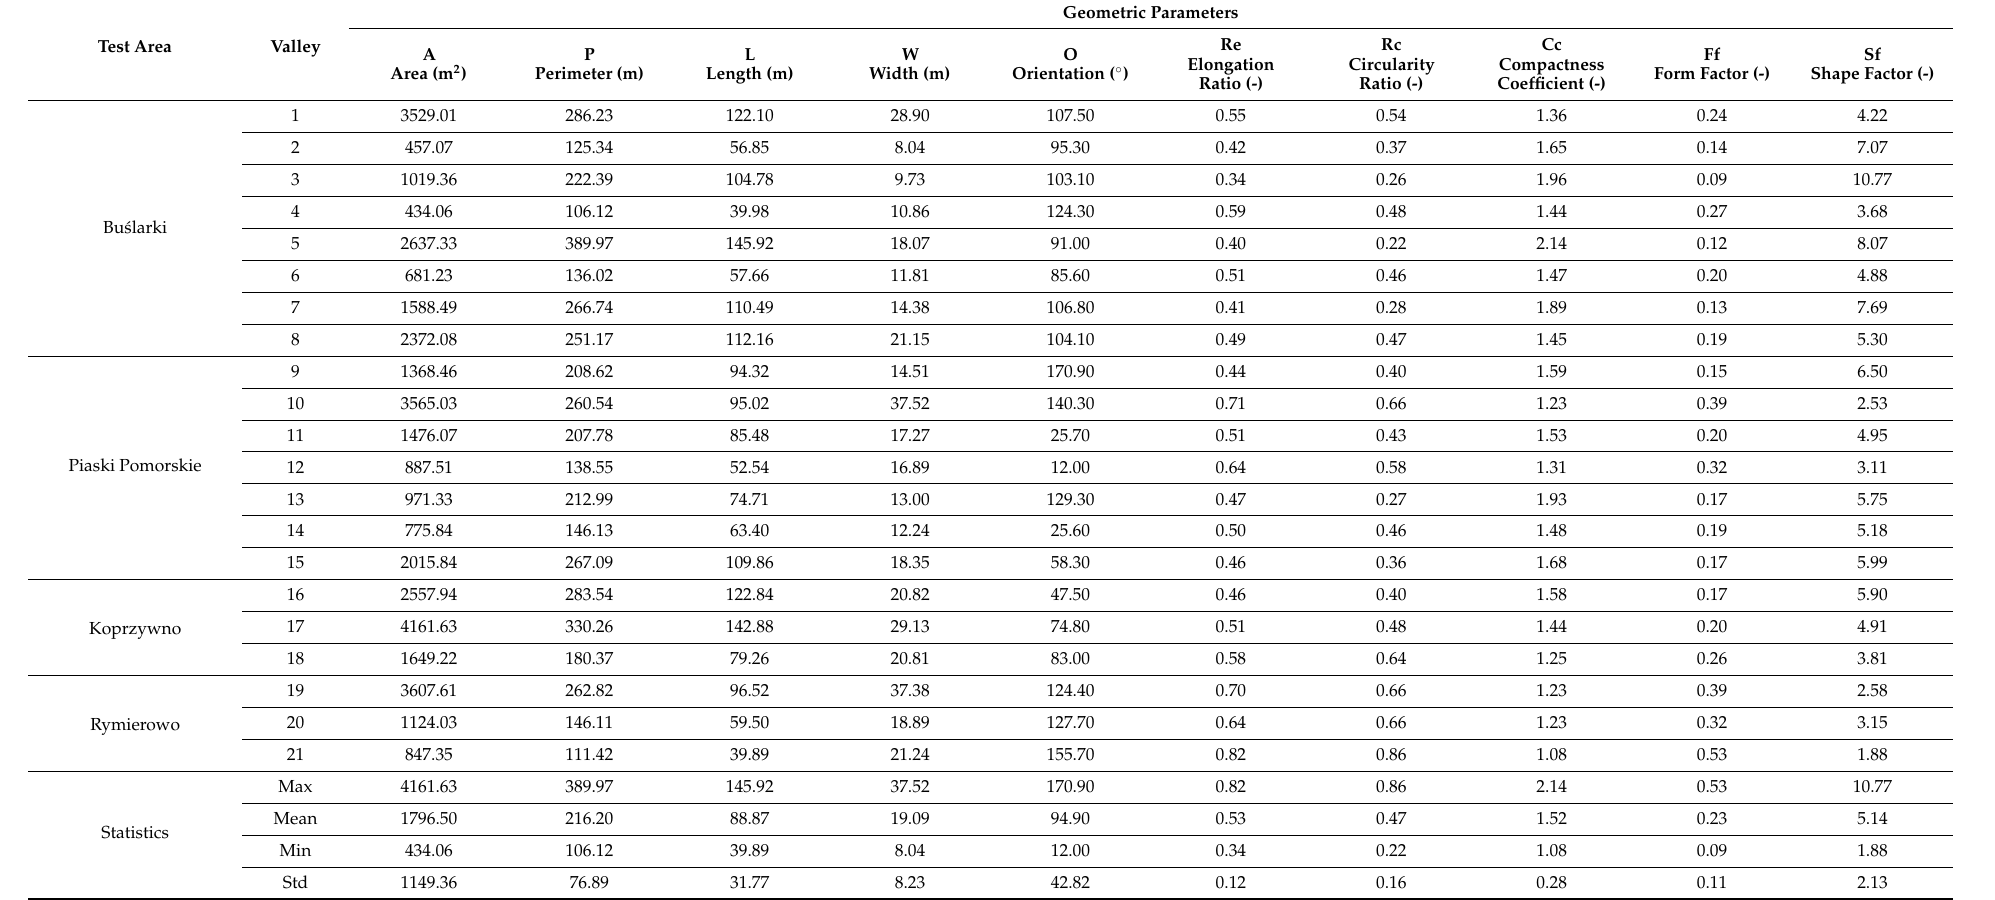
Table 5. Geometric parameters of the erosion-denudation